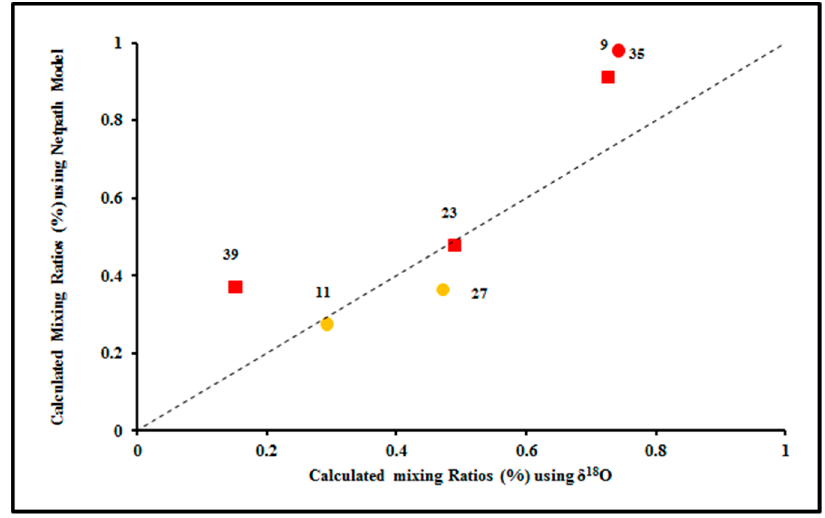
Figure 8. Relation between calculated seawater mixing percent using δ 18 O and NETPATH model.